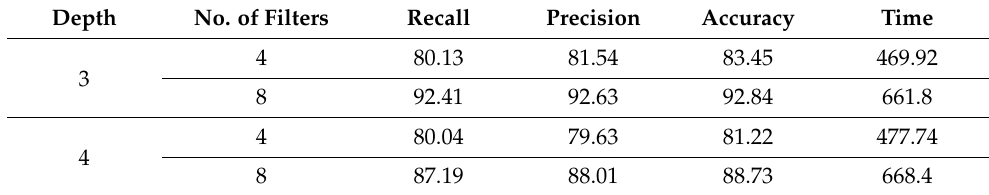
Table 1. Metrics for classification and training times (in minutes) for 4D U-Net models.